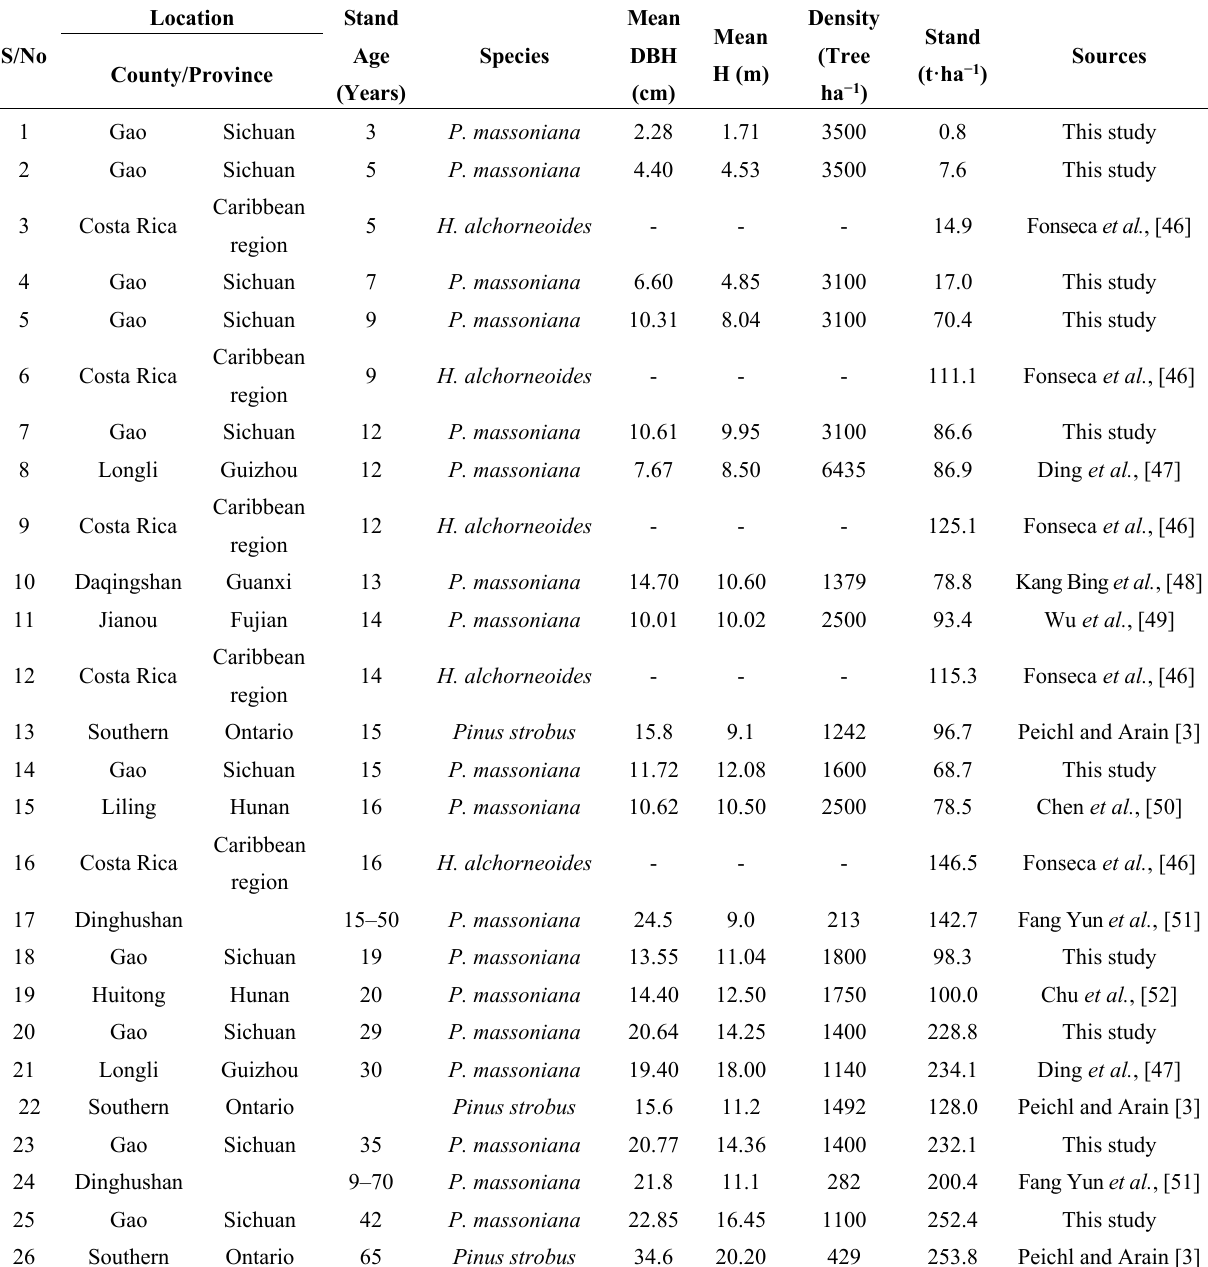
Table 4. Comparison of our study to some published biomass data in subtropical China, the Costa Rican Caribbean region and southern Ontario,